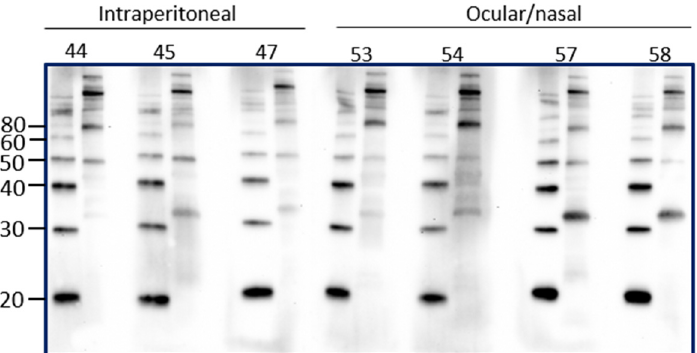
Figure 4. Detection of urinary IgG specific for leptospires in urine from inbred female rats experi- mentally infected using the intraperitoneal route compared to the ocular/nasal route. Representative immunoblots of leptospires with urine collected at PIW4. Molecular mass markers (M) are indicated in kDa and are shown in the left lane of each immunoblot compared to antigen of leptospires in the right lane.